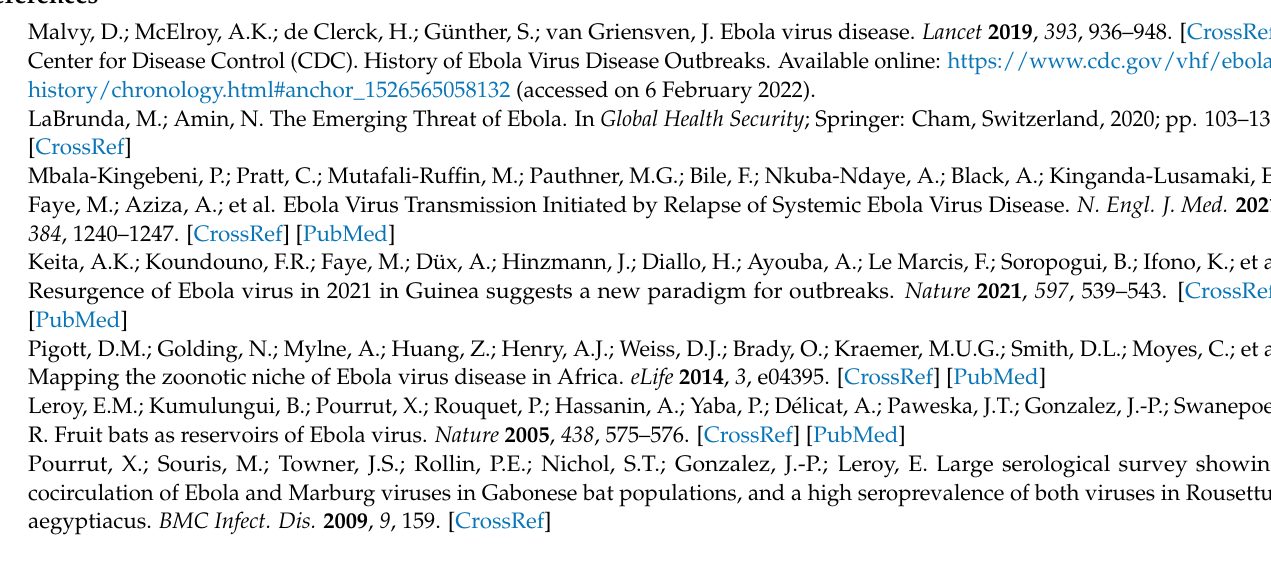
Table S2: Distribution of Eidolon helvum bats per capture session with respect to sex and age, Table S3a: Numbers, percentages and 95% confidence intervals of Eidolon helvum bat samples reactive with the different Ebolavirus antigens according to sex and age and less-stringent cut-off (4 × Standard deviation of negative control samples), Table S3b: Numbers, percentages and 95% confidence intervals of Eidolon helvum bat samples reactive with the different Ebolavirus antigens according to sex and age with stringent (statistical methods) cut-offs, Table S4a: Proportion, percentage and 95% confidence intervals of samples reactive with the different Ebolavirus antigens according to reproductive stage of adult female Eidolon helvum bats with less- stringent (4 × SD of negative samples) cut-off values and Table S4b: Proportion, percentage and 95% confidence intervals of samples reactive with the different Ebolavirus antigens according to reproductive stage of female adult Eidolon helvum bats with stringent (statistical methods, see methods) cut-off